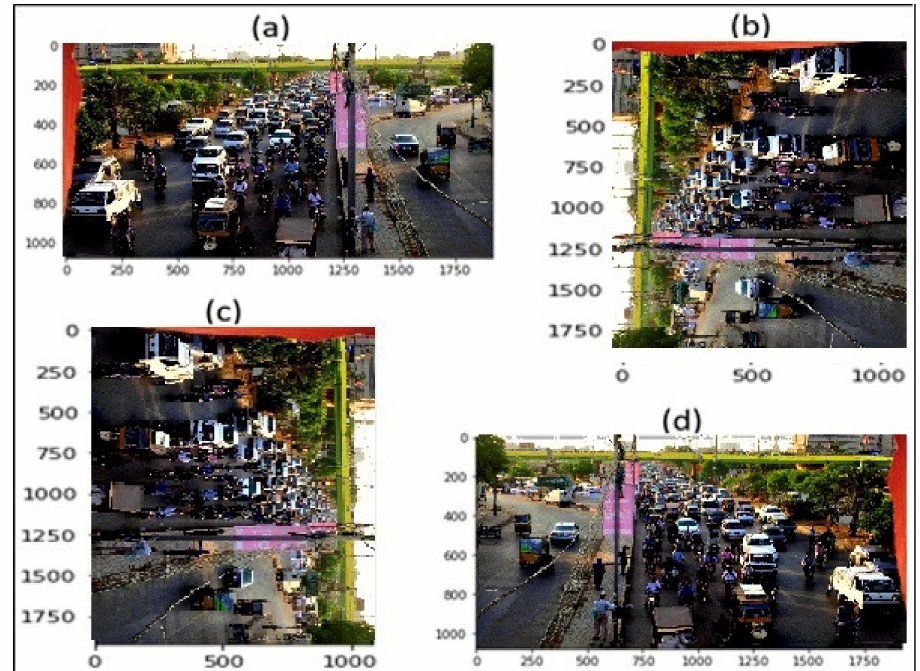
Figure 3. Conventional augmentation applied on a GAN-based synthetic augmented dataset: ( a ) orig- inal synthetic high-contrast image; ( b ) image flipped 90 ◦ ; ( c ) image flipped 270 ◦ ; ( d ) mirror image.